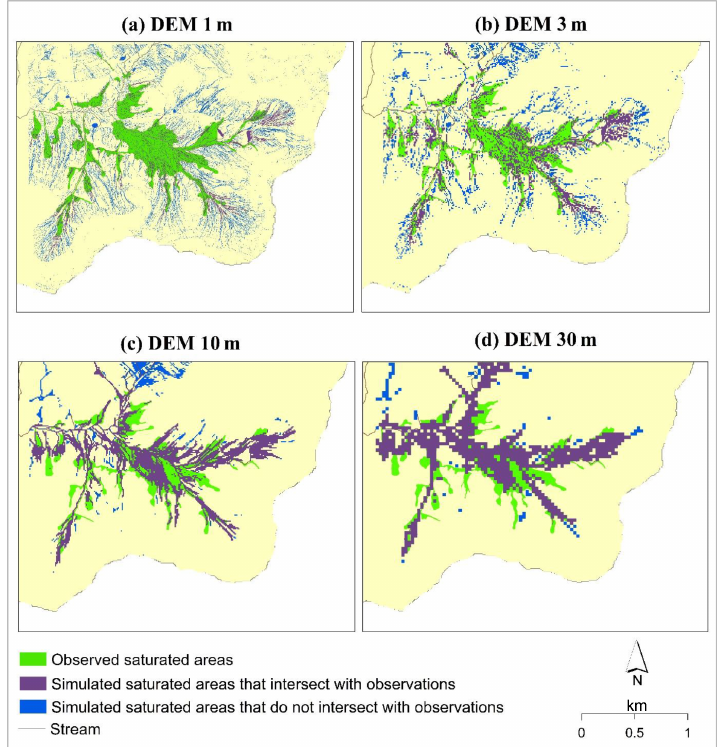
Figure 8. Simulated and observed saturated areas from four SWAT-HS setups using different DEMs, 28–30 April 2006.